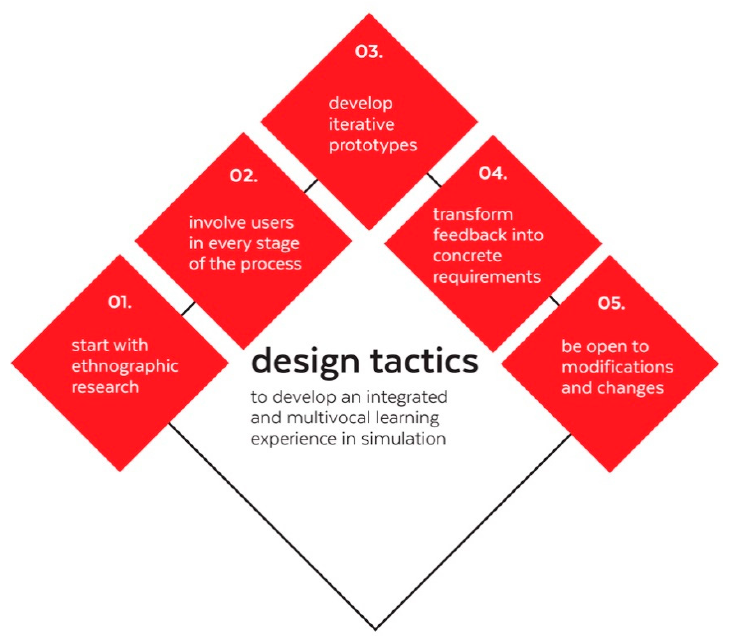
Figure 7. Design tactics used to design a multivocal learning experience.